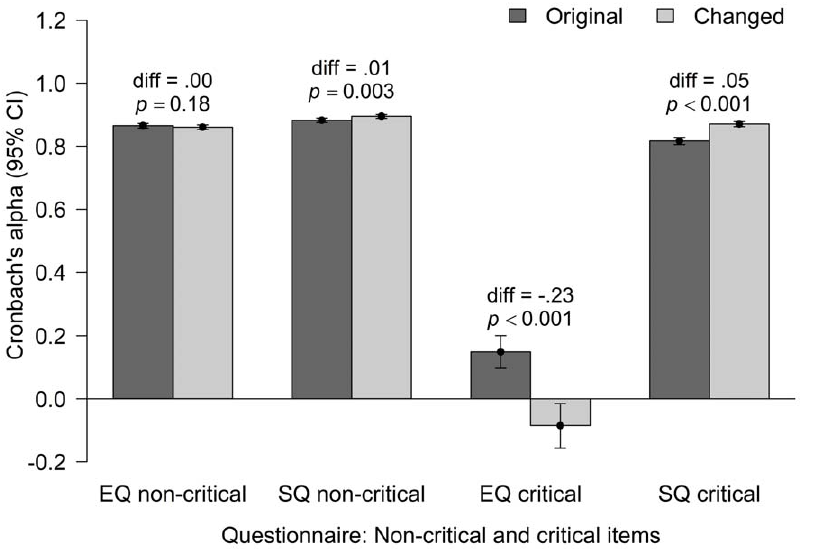
Figure 4. The Cronbach a values for the non-critical items for EQ and SQ (which were the same items) and for the critical items for the EQ and SQ (where the original versions were negatively phrased and the changed versions were positively phrased).